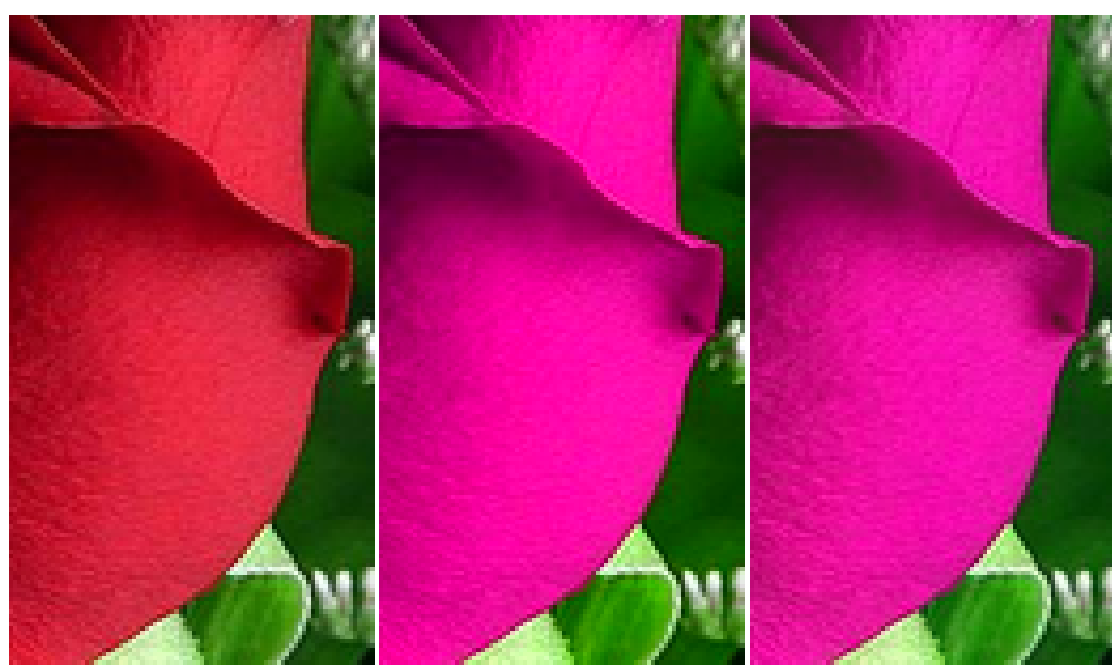
Figure 3. Loss of details in the simple daltonisation algorithm for an RG α = 1 dichromatic observer. Left to right : original image, simple daltonisation, and anisotropic daltonisation.